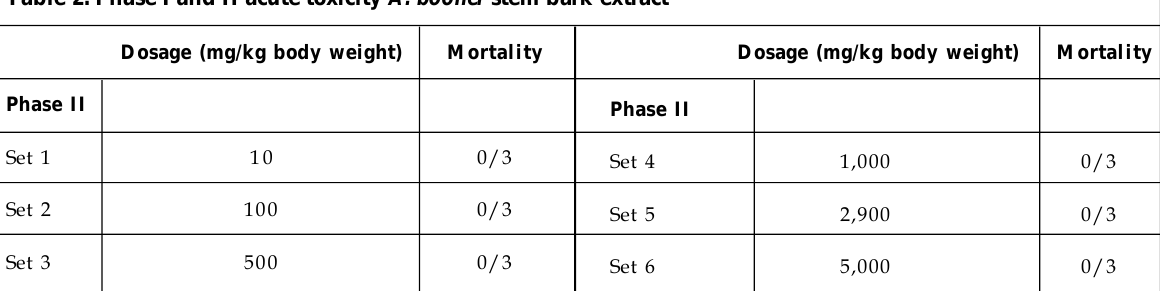
Table 2: Phase I and II acute toxicity A. boonei stem bark